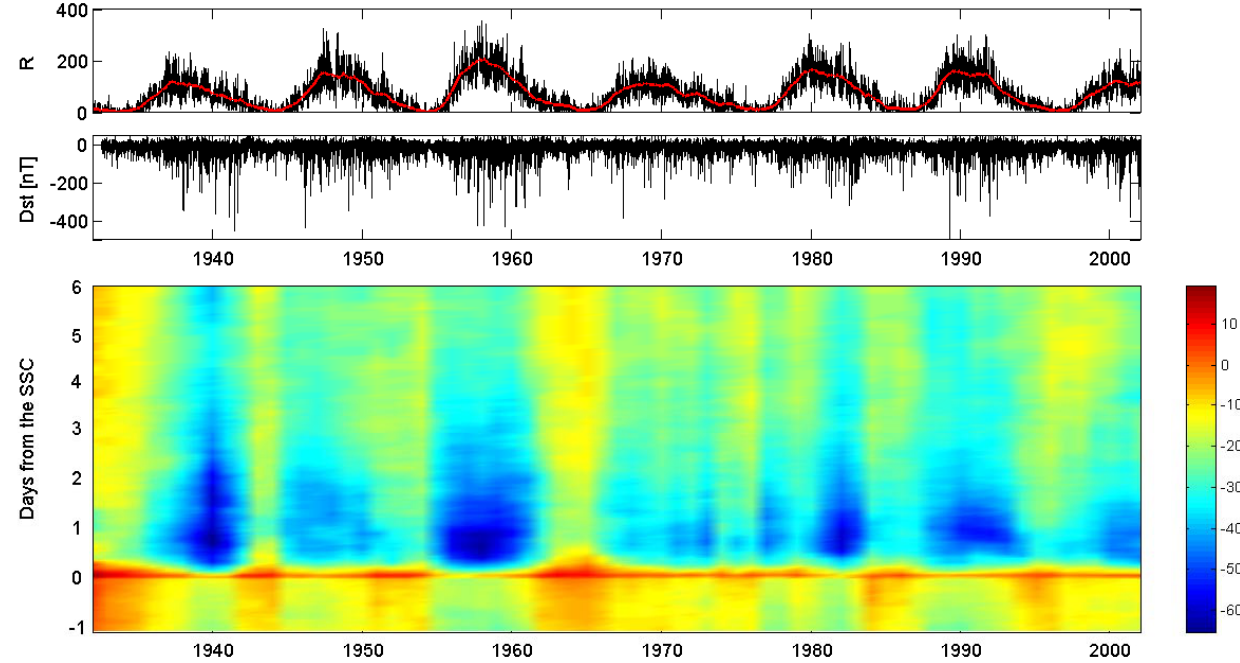
Fig. 9. Top: daily sunspot number in 1932–2002. One-year running mean of the sunspot counts is depicted in red. Center: reconstructed D st index in 1932–2002. Bottom: annually calculated superposed storm curves using the reconstructed D st in